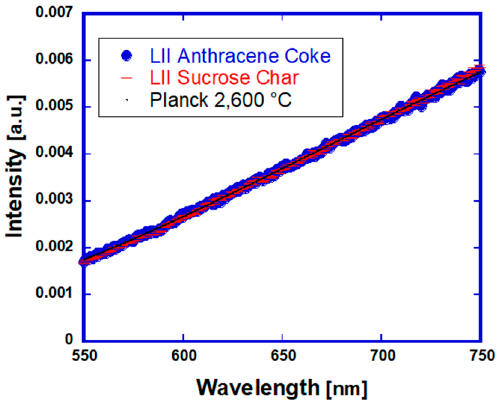
Figure A1. LII spectra from CO 2 laser heated anthracene coke and sucrose char fit to black-body distribution.